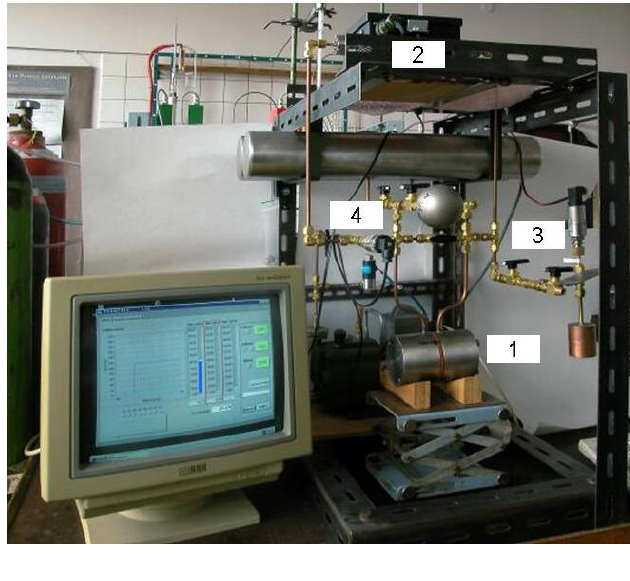
Figure 5. Quasi-stationary permeation cell. ( 1 ) The cell; between left and right chambers there is holder made of porous material; ( 2 ) Pressure difference transducer; ( 3 ) Gas manifold; ( 4 ) Pressure